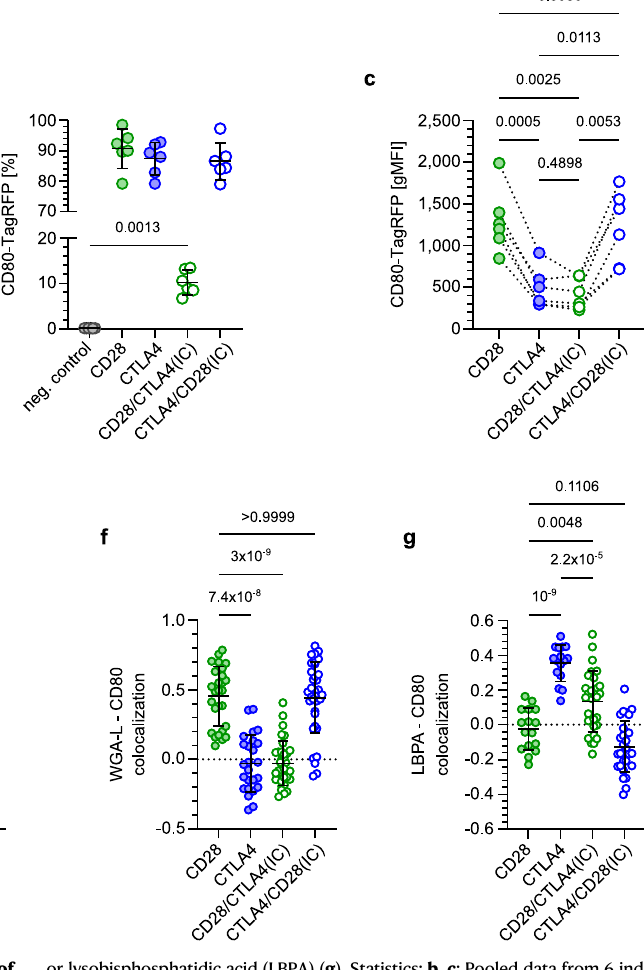
or lysobisphosphatidic acid (LBPA) ( g ). Statistics: b , c : Pooled data from 6 inde- pendent experiments. Repeated measures one-way ANOVA with Tukey ’ s